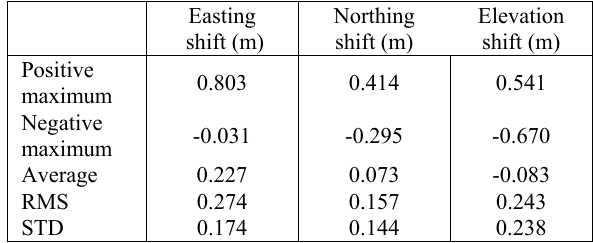
Figure 8. The misalignment of the BLS patch centre points in the elevation